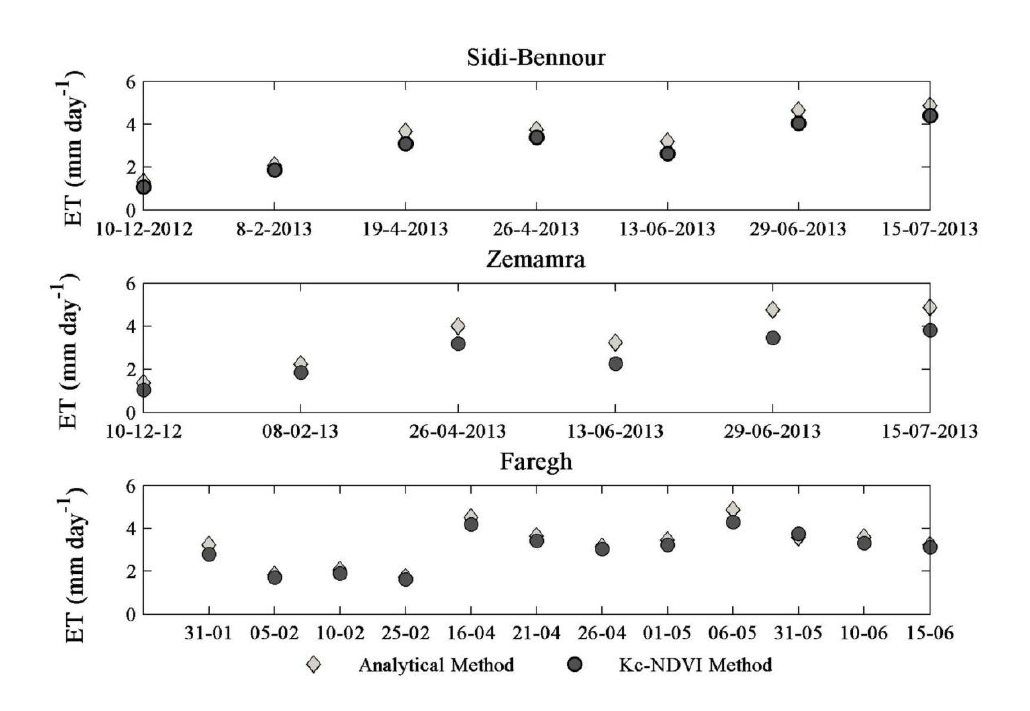
estimates with the K -NDVI method and the c c